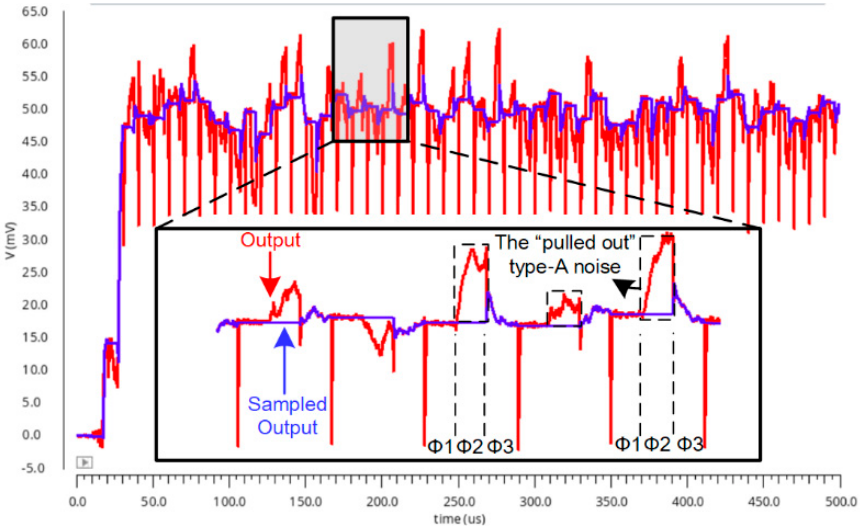
Figure 11. The transient output waveform of RNSF-CVC.